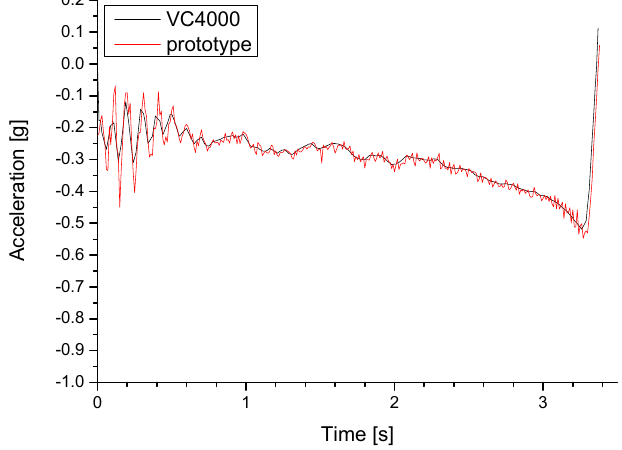
Figure 10. Measured acceleration during braking (passenger car on wet skid-pad, 40 km/h, test #20).